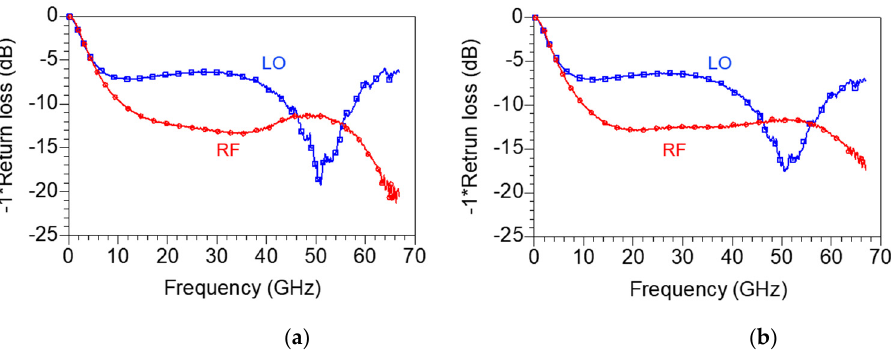
Figure 18. Measured RF and LO return loss under bias conditions of ( a ) V DD = 1.5 V, V GG1 = 0.6 V, V GG2 = 0.7 V and ( b ) V DD = 1.5 V, V GG1 = 0.5 V, V GG2 = 0.5 V.